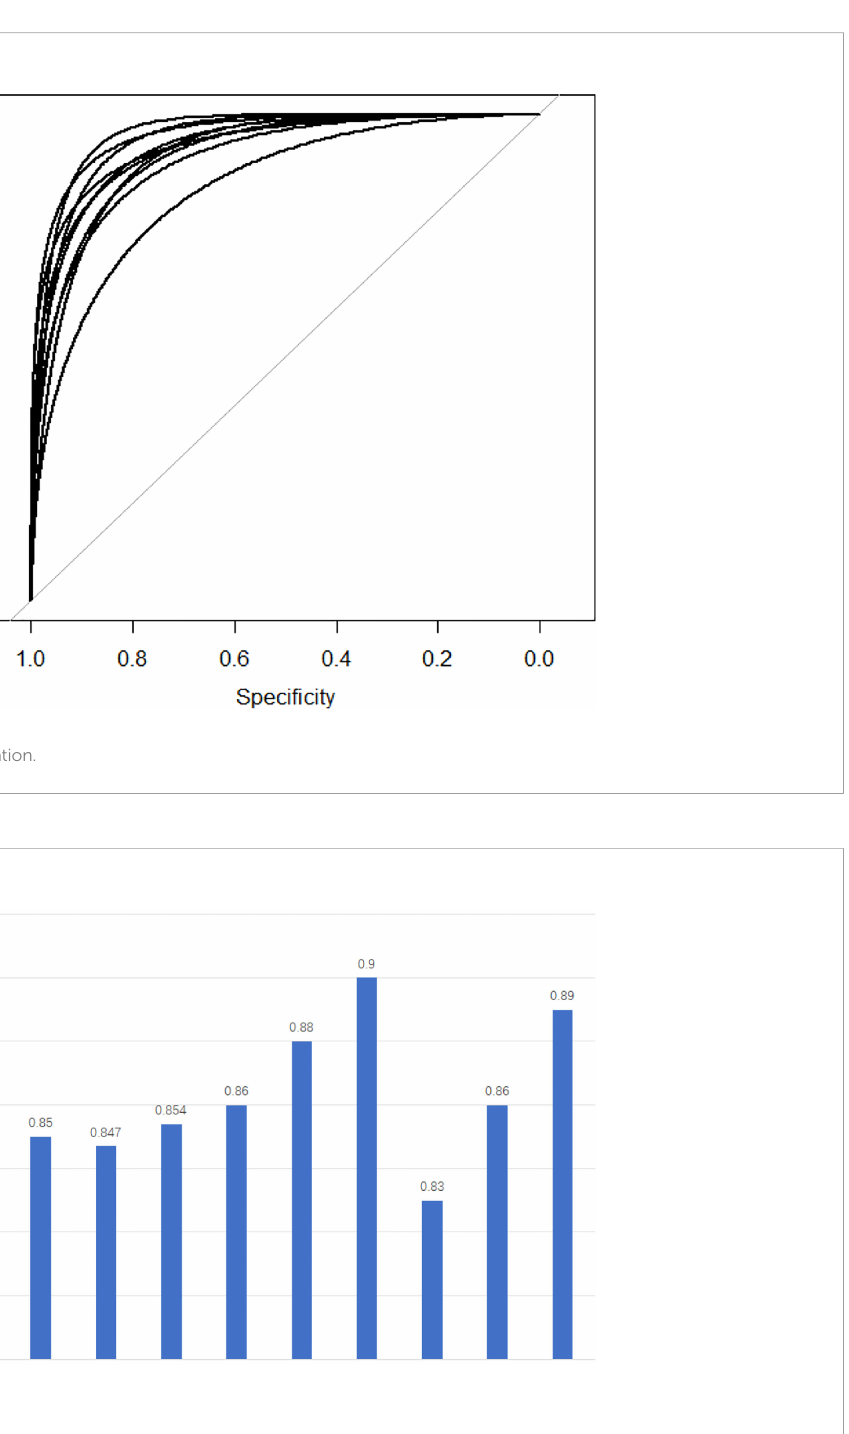
FIGURE 3 AUPR of GCNLMF in 10-cross